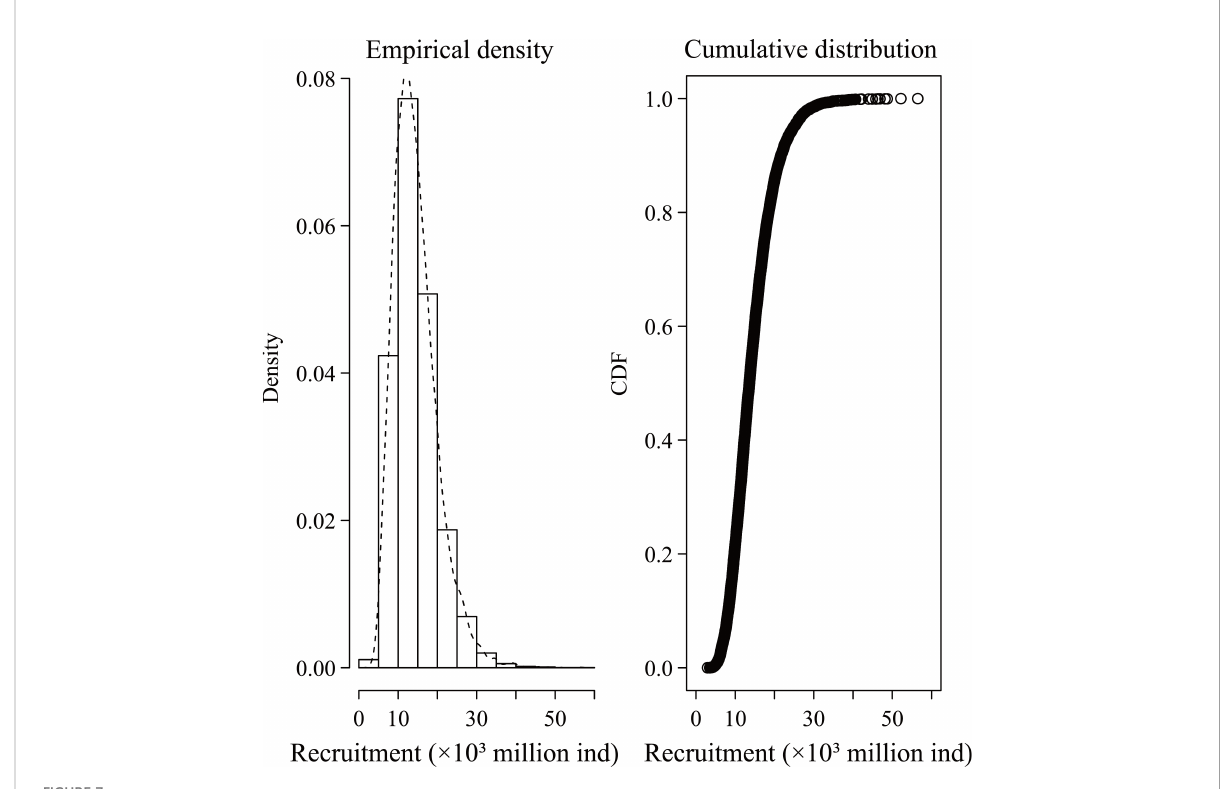
FIGURE 7 Histogram and CDF plots of an empirical distribution for a continuous